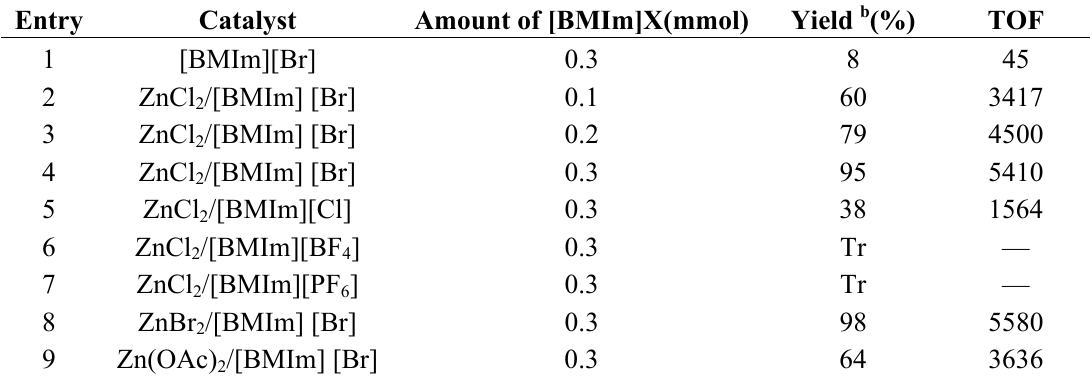
Table 1. Effects of different zinc compounds combined with [BMIm][X] on the coupling reaction of CO and PO a 2